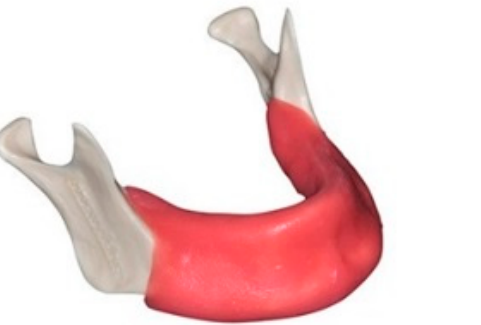
Figure 1. Cast with the scan-prosthesis.